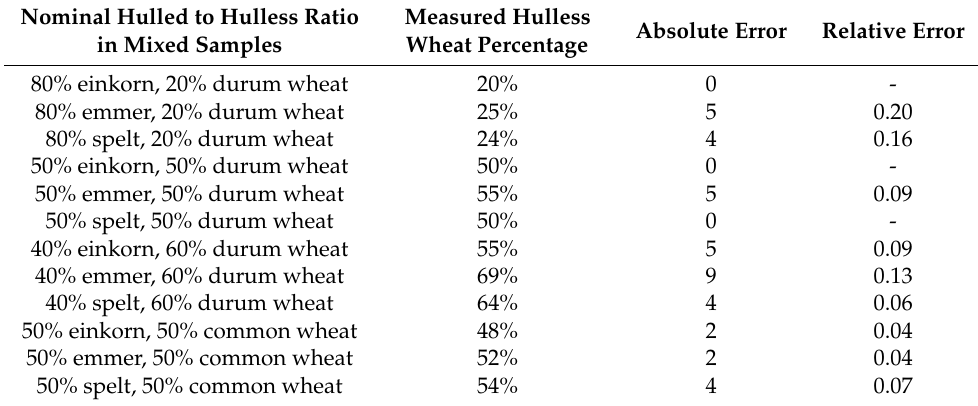
Table 4. Actual hulless wheat percentages in comparison with those experimentally determined in samples obtained by mixing DNA extracted from pure einkorn, emmer, spelt, common and durum wheats.